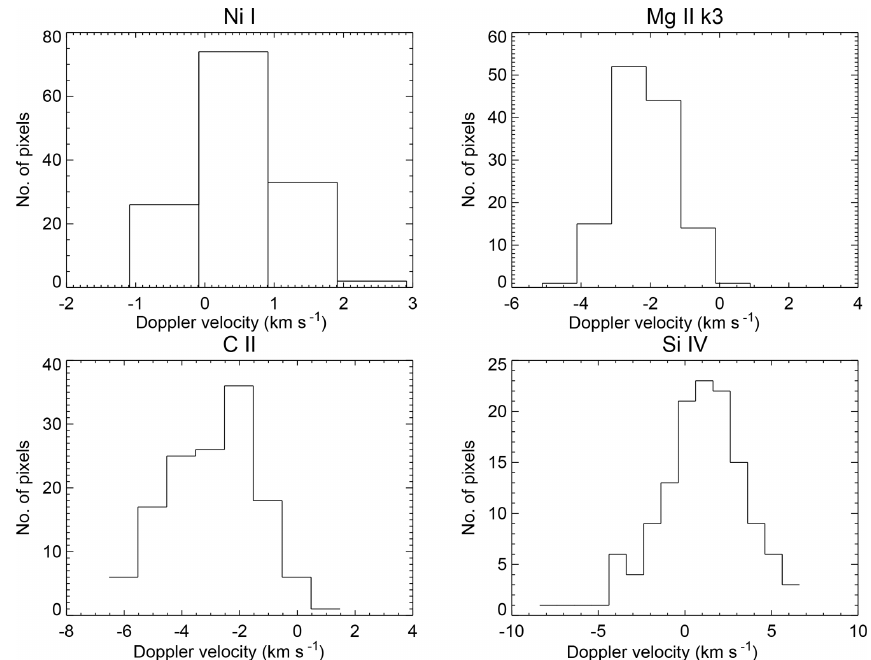
Figure 9. The velocity distributions for different spectral lines corresponding to different temperatures at box B4.